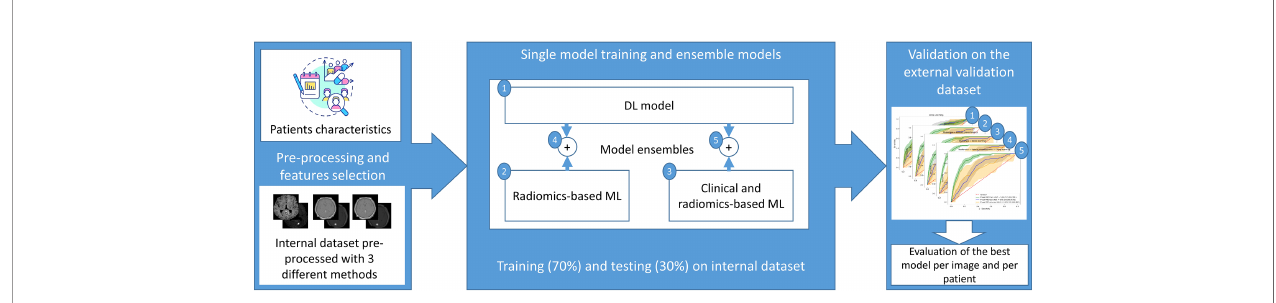
FIGURE 4 | General work fl ow of the model training process: fi rst, the MRI data was pre-processed using 3 pre-processing methods, the most suitable pre- processed set of images was selected according to the radiomics-based model or the DL model performance on the internal test dataset, then the models were ensembled or trained separately, and fi nally the performance of each model was computed on the external dataset.